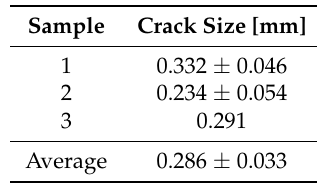
Table 1. Length of crack in CT specimen at earliest detection using an UAM-embedded FBG sensor located 3 mm from the notch. Tolerances are due to crack entering a DIC speckle and consequently being unable to optically determine a precise